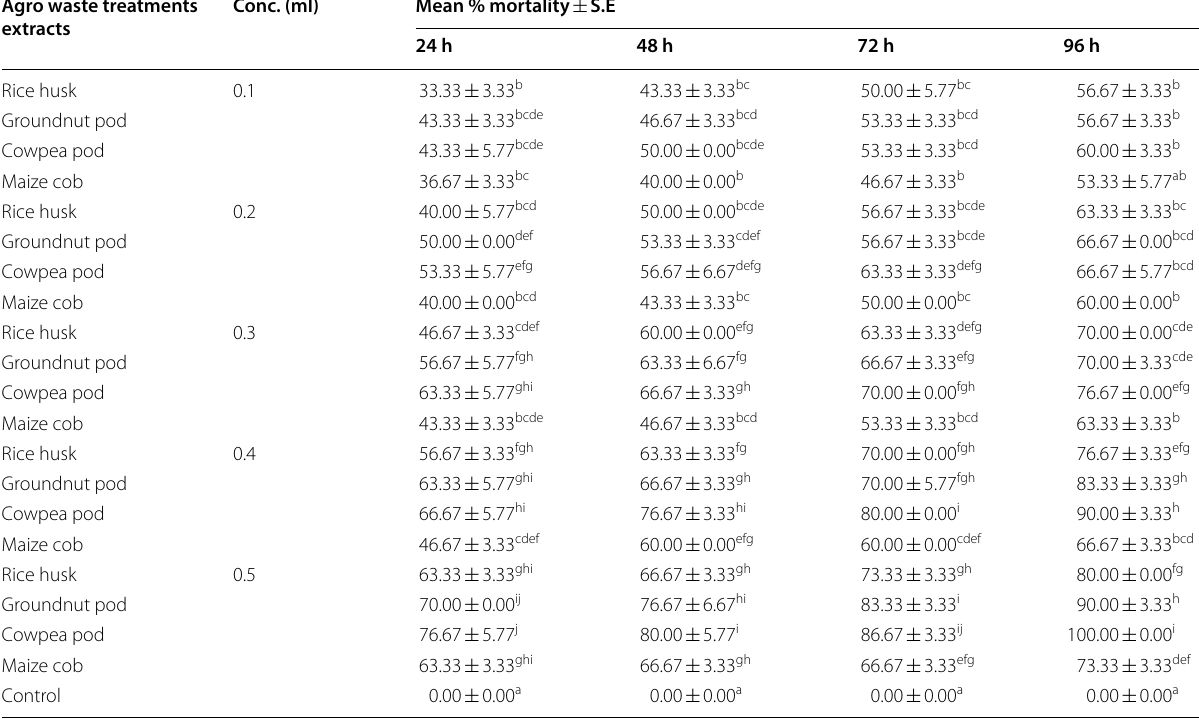
Mean followed by the same letters within the same column are not significantly different ( p > 0.05)